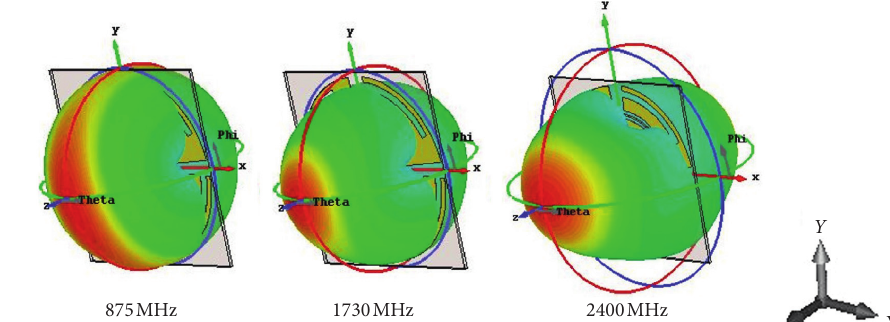
Figure 14: 3D radiation patterns of antenna.